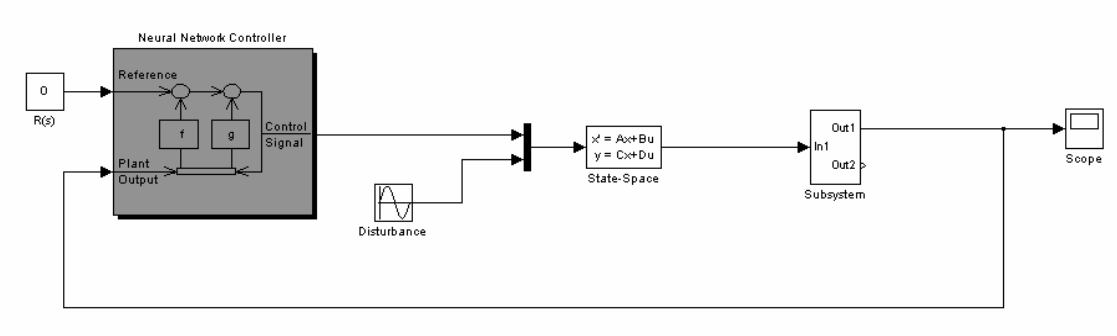
Fig. 24. Matlab realization of the system.